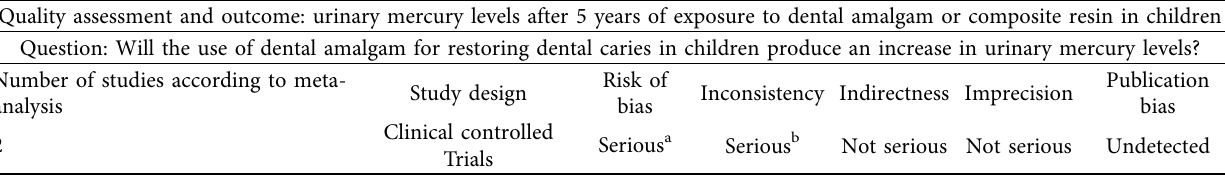
Table 3: GRADE summary of findings for meta-analysis on urinary mercury concentration after 5 years of exposure to dental amalgam or composite resin in